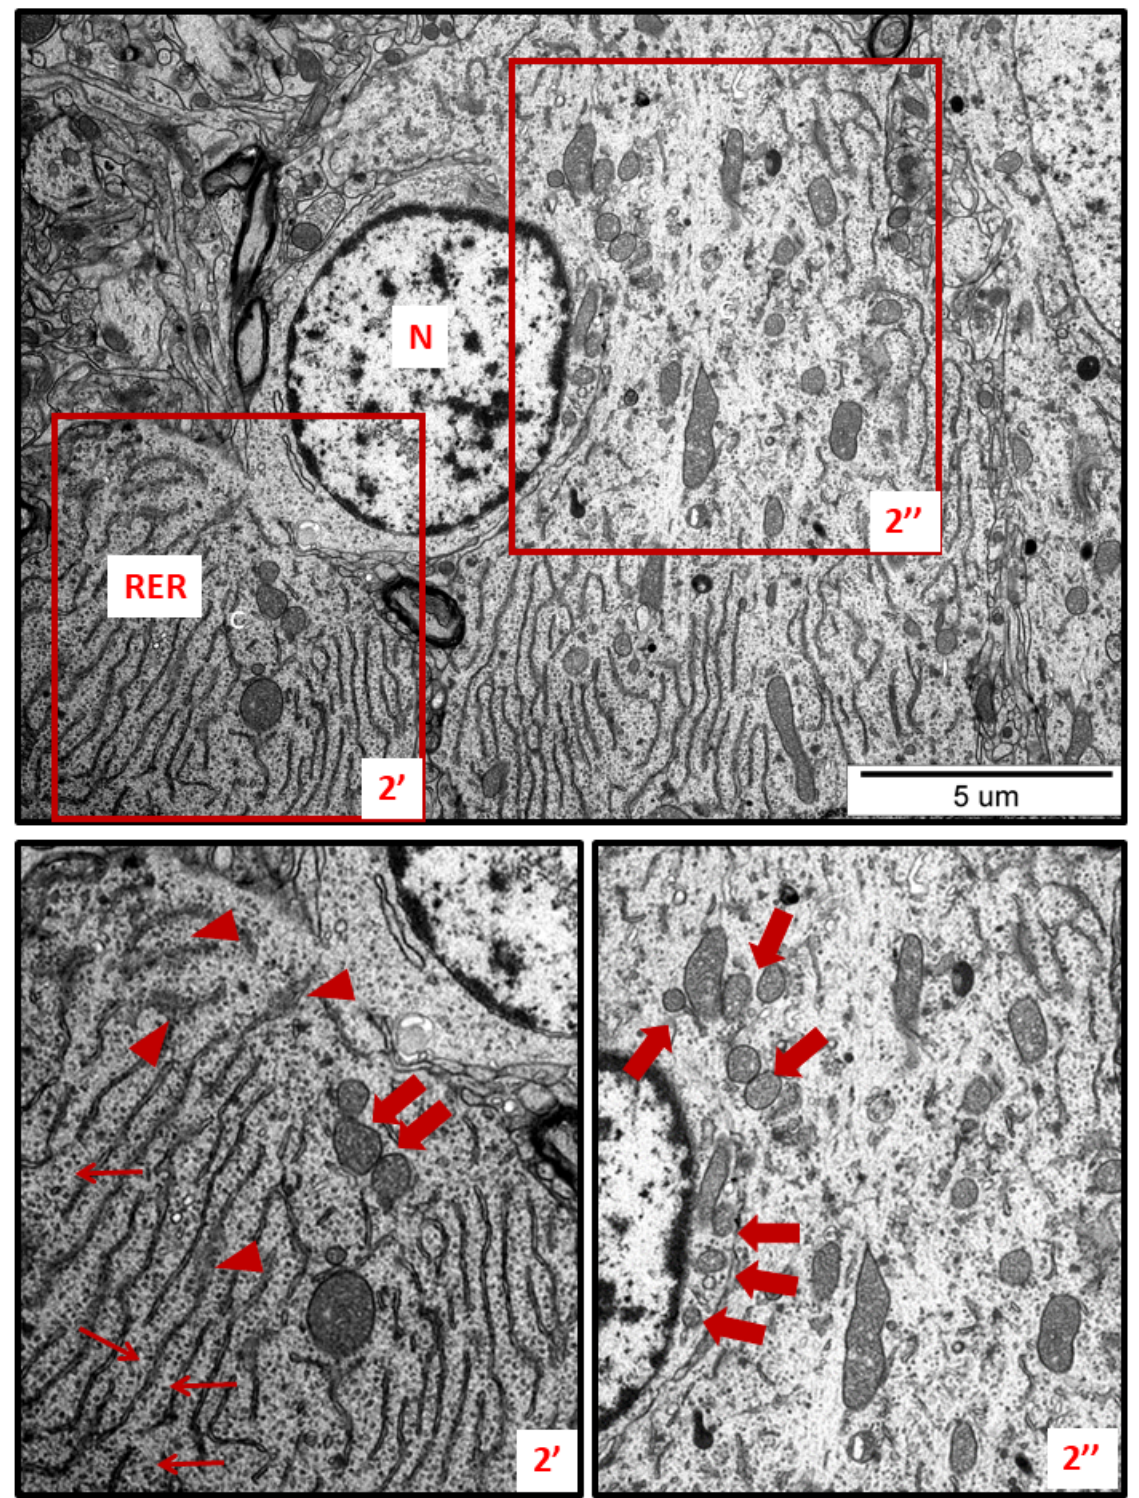
Figure 2. Representative TEM micrographs showing ultrastructural changes in subcellular struc- tures of neurons in cerebral sections obtained from AgNP-treated rats. RER—rough endoplasmic reticulum; N—nucleus. Enlarged and thickened cisternae of RER (2 ′ ); swollen fragments of RER with blurred structure (arrowheads); ribosomes detached from RER lying free in the cytoplasm (thin arrows); fragmentation of mitochondria (thick arrows). Insets (2 ′ , 2 ″ ) were magnified 2×. Images are representative for each of the 3 animals.